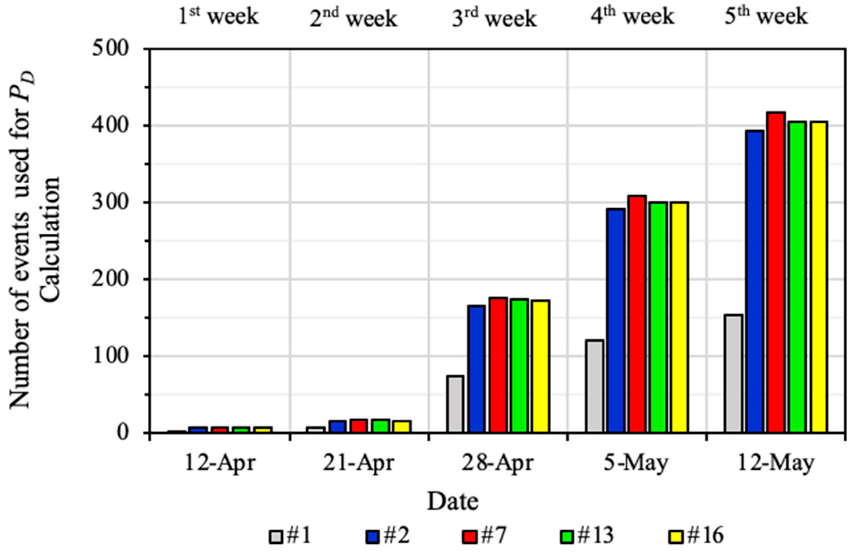
Figure 6. Number of seismic events used for weekly P D calculation for different geophones between 12 April and 12 May